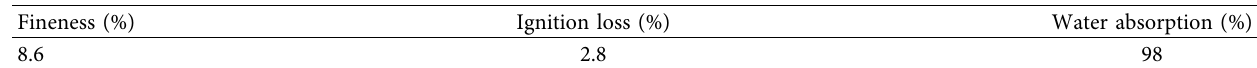
Table 2: Physical properties of fly ash.